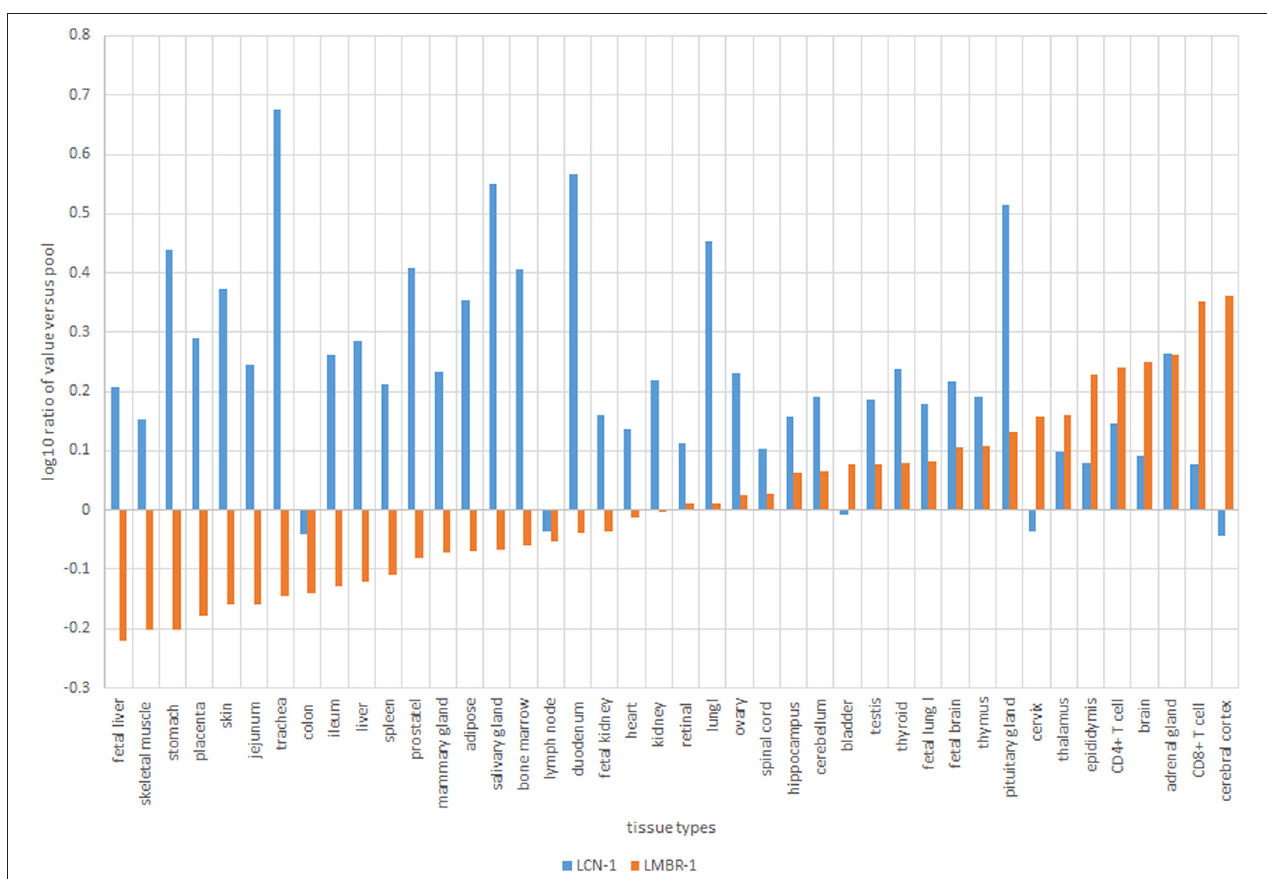
FIGURE 4 | Normalized values of expression transcripts for tear lipocalin, blue (LCN-1) vs. lipocalin-interacting membrane receptor, orange